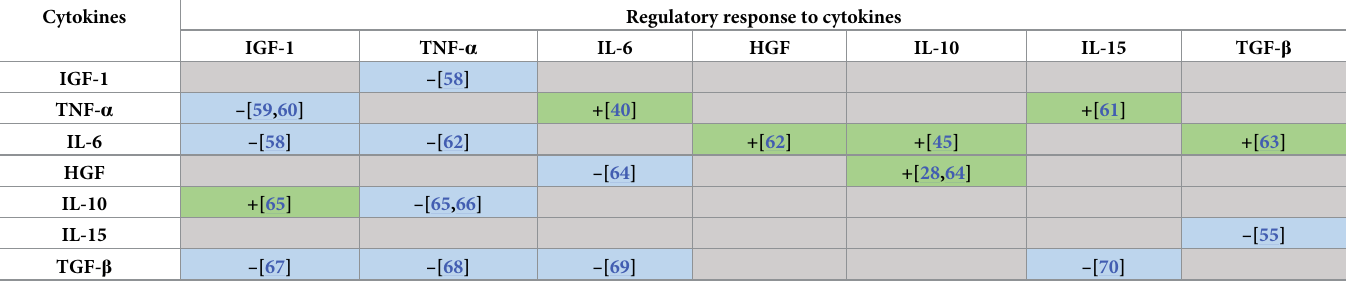
Table 1. Interactions between selected cytokines and growth factors involved in the muscle repair process. The effect of cytokines in the first column on the cytokines on the subsequent columns, e.g., IGF-1 decreases TNF-a levels in the first row. + denotes up-regulation and–denotes down-regulation as based on the listed references.